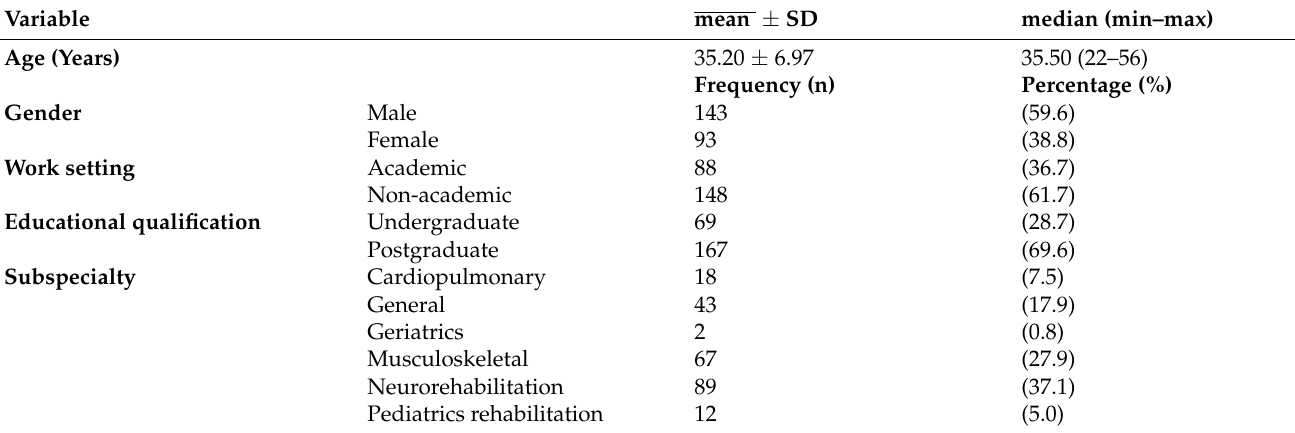
Table 2. Logistic regression to assess the factors associated with AI.